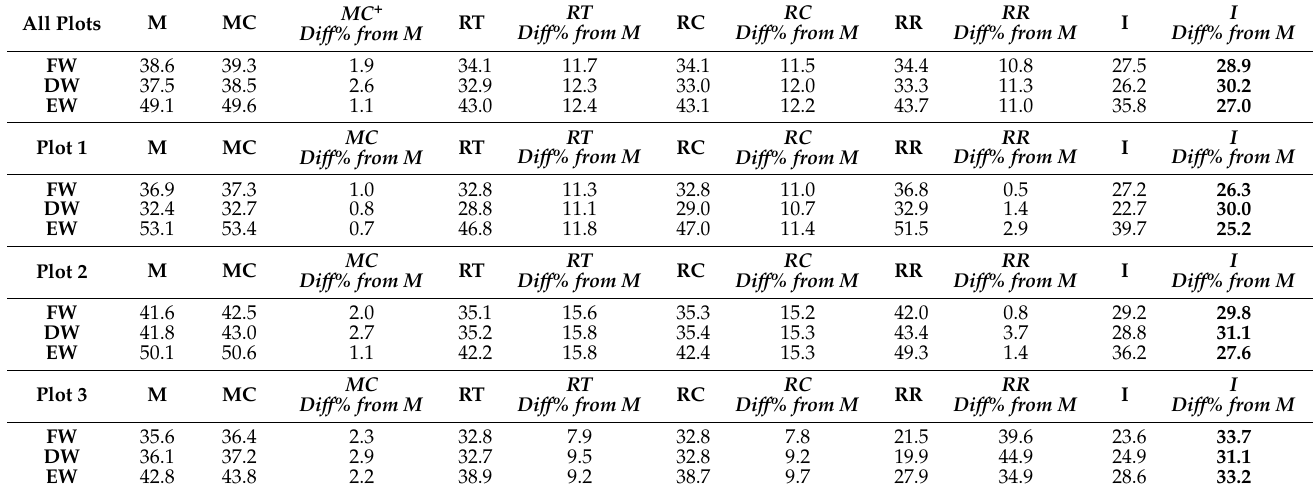
Table 4. Difference (Diff) in CV values (%) between the measured data (all data) ( M ) and those values derived from the sampling methods: MC, RT, RC, RR, and I, where: M : Measured (all data); MC : Measured cut (without the measurements from the upper part area—lines 20 to 25); RT : Missing values were replaced by the total average of all values; RC : Missing values were replaced by the average of the column, where the missing value belongs to; RR : Missing values were replaced by the average of the row, where the missing value belongs to; I : Interpolation; FW : Fresh weight; DW : Dry weight; EW : Ear weight. Note: numbers in bold highlight the parameters of